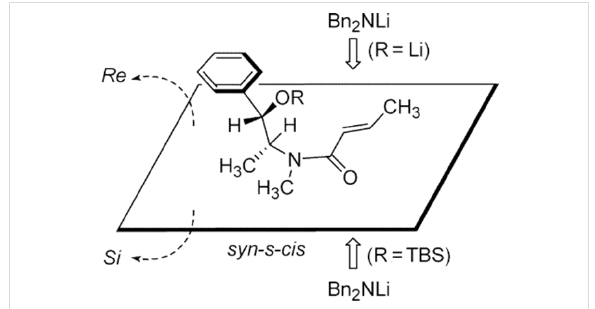
Figure 4: Proposed model accounting for the diastereoselectivity observed in the 1,4-addition of Bn 2 NLi to α , β -unsaturated amides at- tached to ( S,S )-(+)-pseudoephedrine. Reprinted with permission from J. Org. Chem. , 2005 , 70 , 8790–8800. Copyright 2005 American Chem- ical